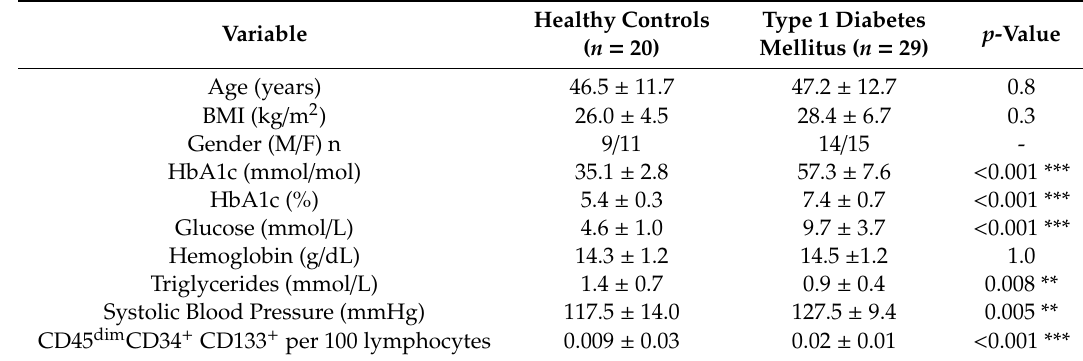
Table 1. Subjects’ clinical and metabolic characteristics.